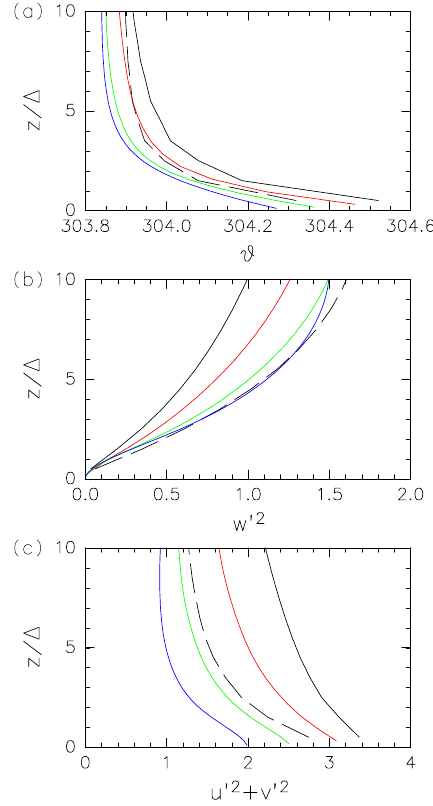
Figure 7. The vertical profiles against z/(cid:49) of (a) the potential tem- perature, (b) variance of the vertical velocity, and (c) variance of the horizontal velocity in the 10mAR1 (black solid line), 10mAR2 (red solid), 10mAR5 (green solid), 10mAR10 (blue solid), and 30mAR1 (black broken)